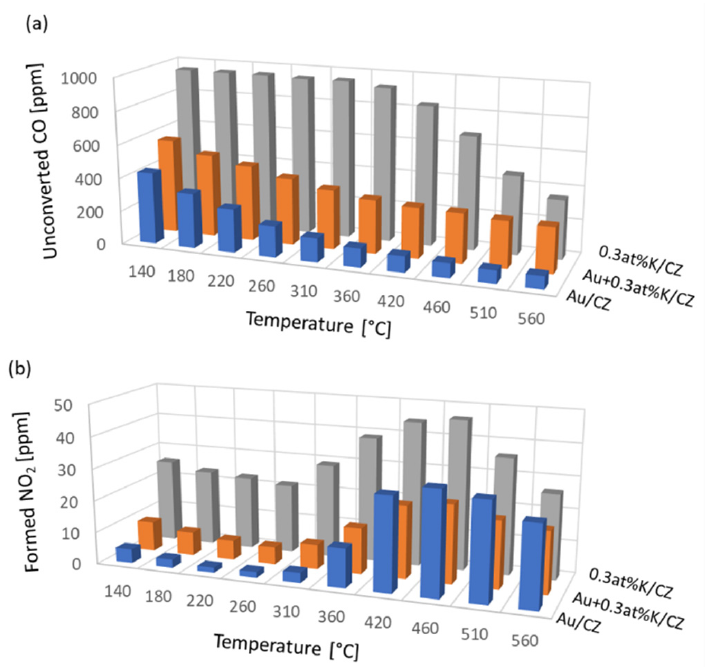
Figure 9. Results from complex stream activity tests: ( a ) CO oxidation and ( b ) NO 2 formation.